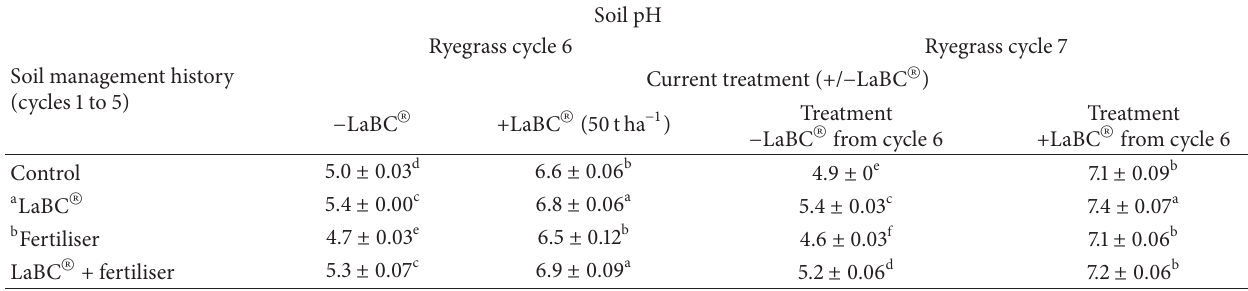
Table 7: Soil pH in ryegrass cycles 6 and 7 with reapplied LaBC Ⓡ (+/ − ) as influenced by residual effects of soil amendments from previous management history.